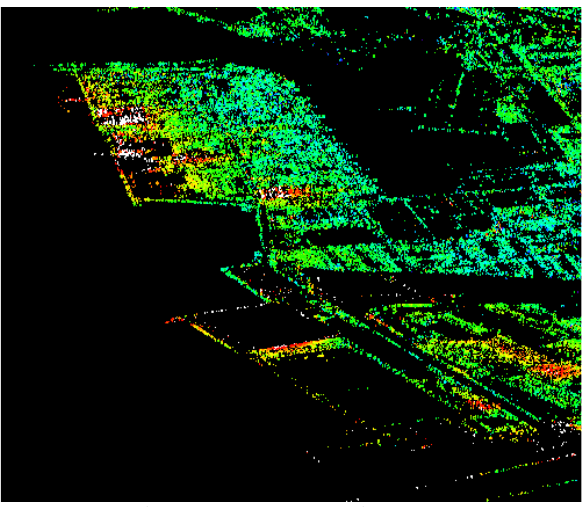
Figure 2. Deformation velocity map from Fast-Sup-GLRT. The colour scale ranges from – 10 to + 10 mm/yr.